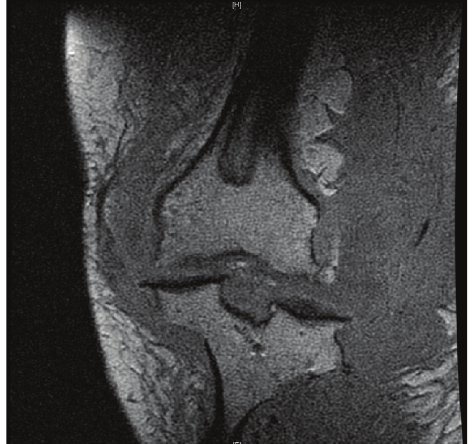
Figure 4: MRI demonstrates bony deformities of distal femur and proximal